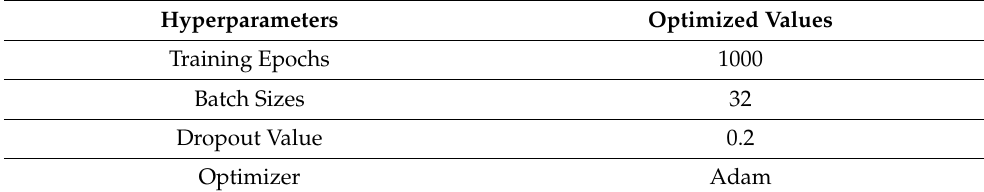
Table 4. Optimized hyperparameters of the conv-5 DCNN.